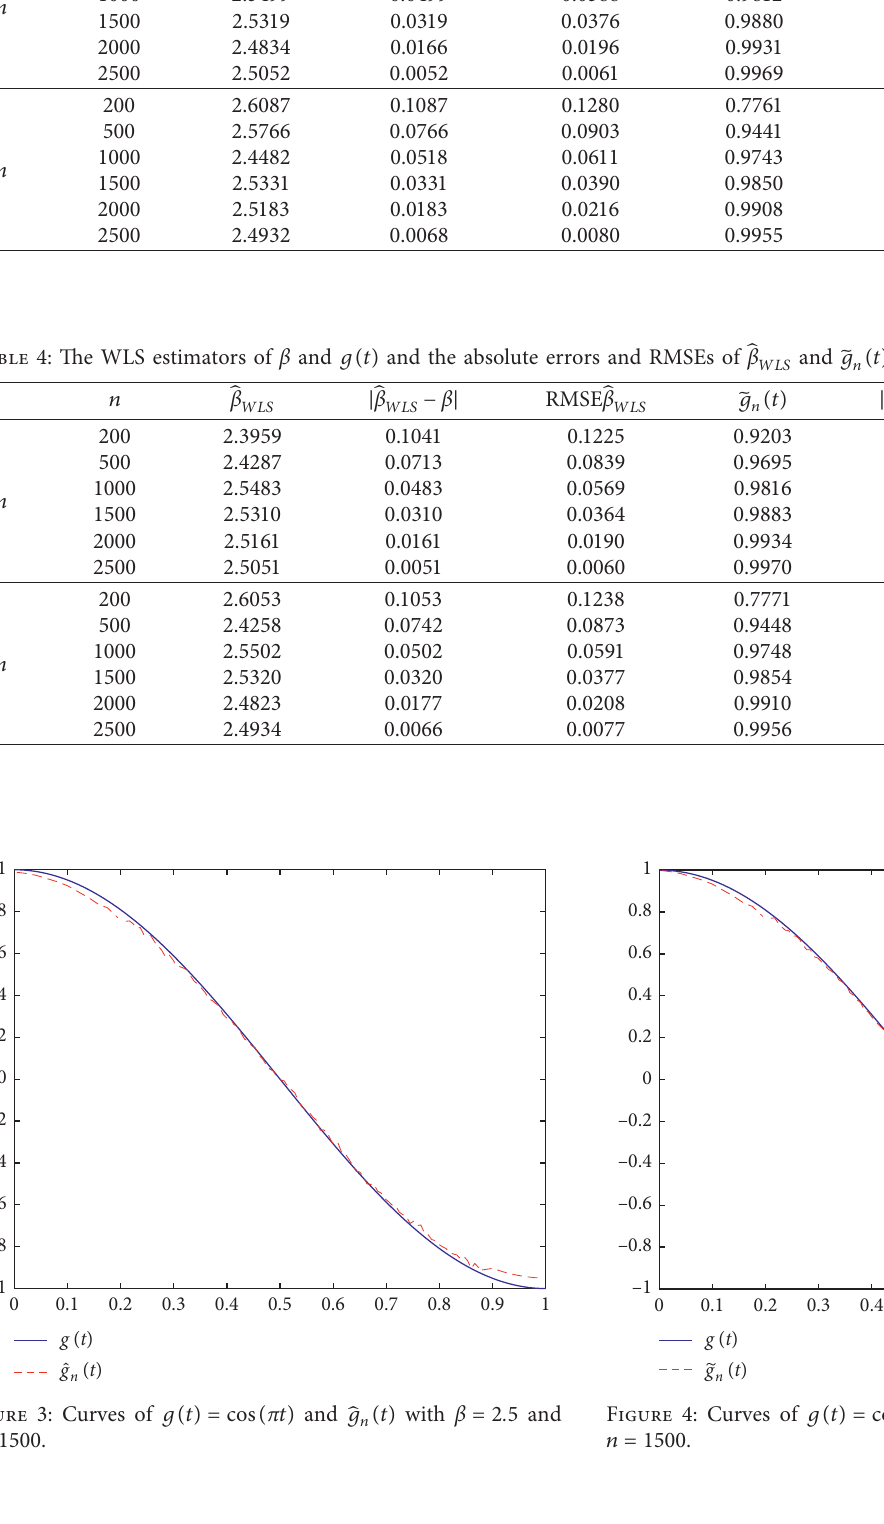
Table 3: The LS estimators of β and g ( t ) and the absolute errors and RMSEs of 􏽢 β